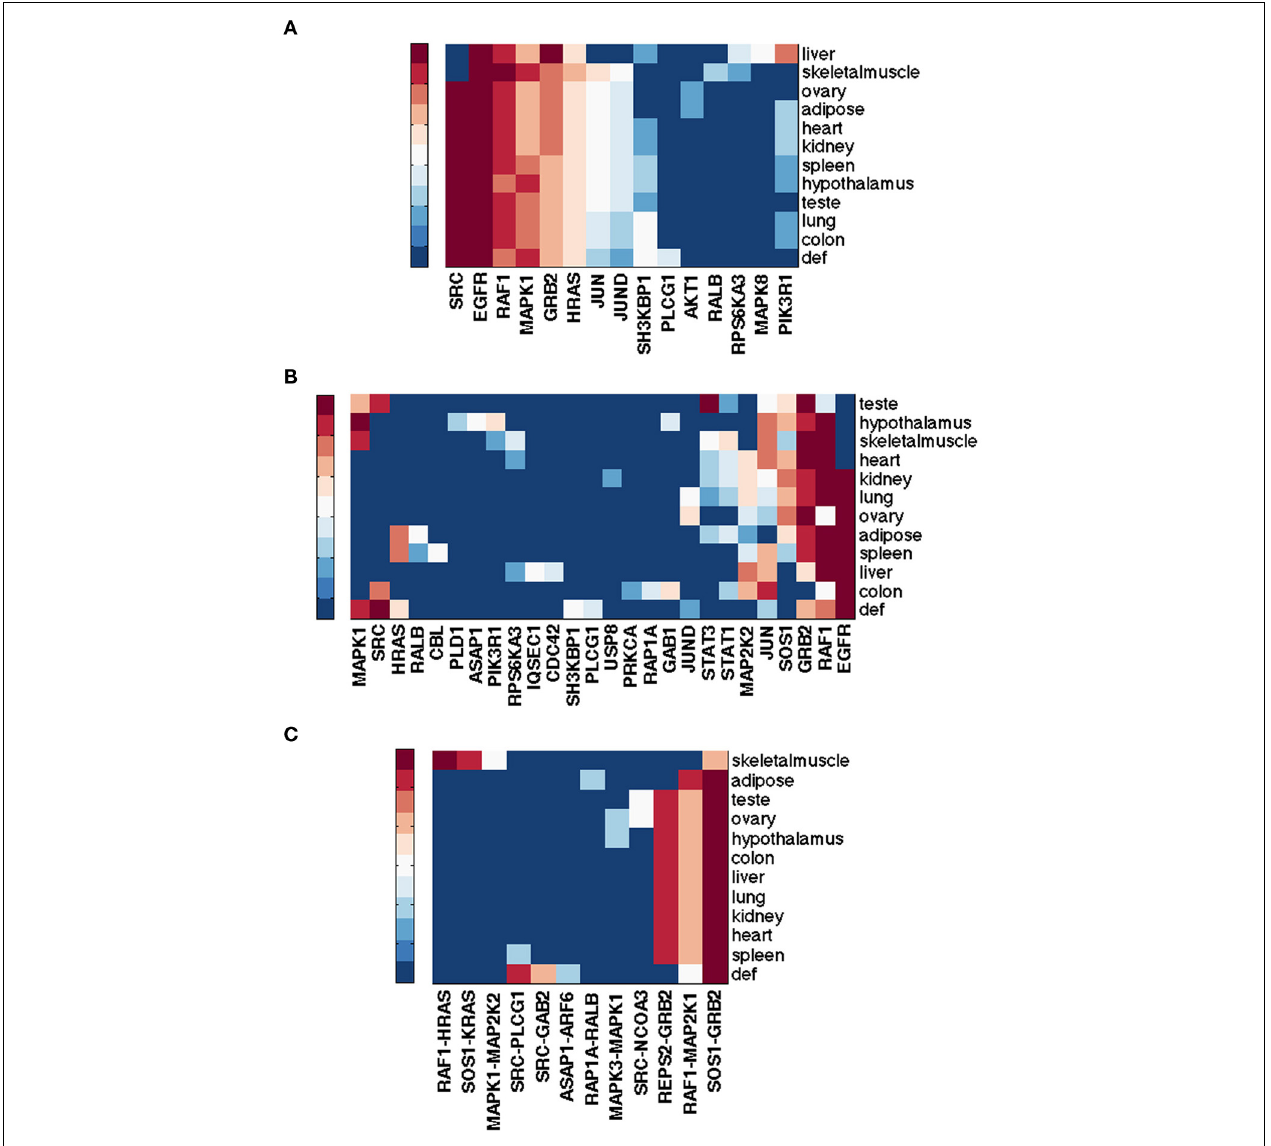
FIGURE 4 | Top ranked nodes of EGFR pathway conditioned on eleven normal human tissues from RNA-Seq Atlas. Ranks range from 1 (dark red) to 10 (blue), and > 10 (the darkest blue) for (A,B) ; from 1 (dark red) to 5 (blue), and > 5 (the darkest